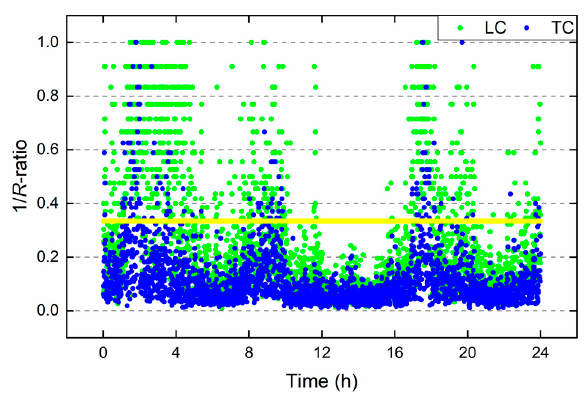
Figure 6. The reciprocal ratio values in ambiguity resolution (AR). The green and blue dots are for the LC and TC models, respectively. The yellow line is the threshold of ambiguity fixing with respect to the ratio value, where 1/3 was employed. There were 2124 and 2734 epochs when the ratio test was passed for LC and TC models.